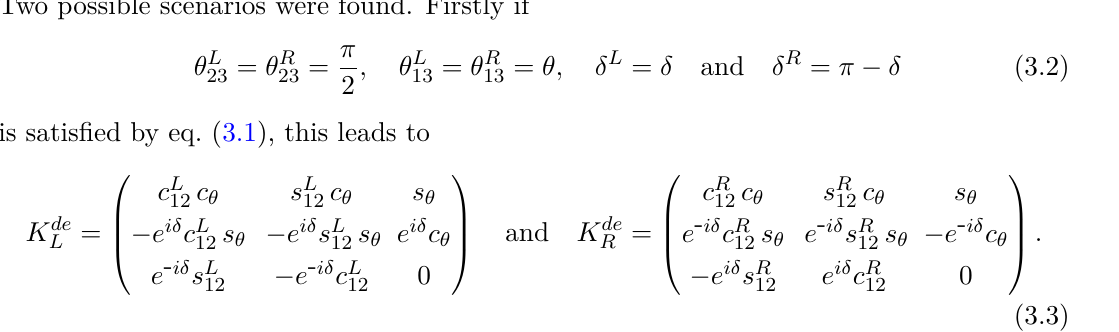
) and ( K de ) need to be non-zero for pi qj L/R L/R where p, q correspond to the valence down-type quarks, µ